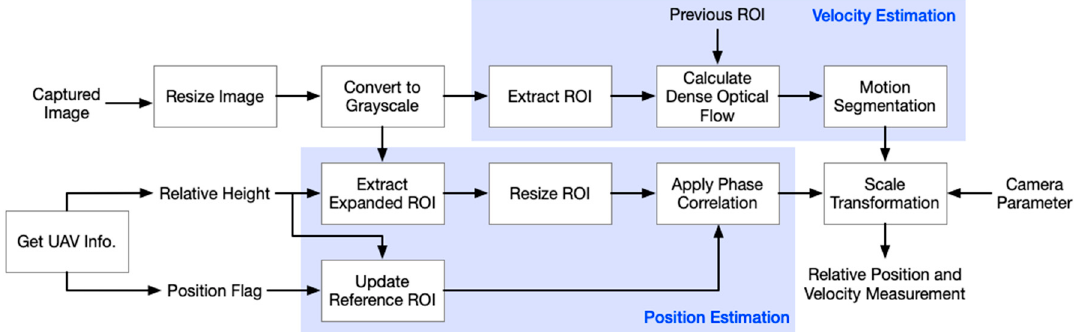
Figure 2. Software flowchart of the vision processing system. The velocity estimation is based on the Grunnar–Farnebäck algorithm, and the position is calculated by the proposed multi-scale phase correlation method.